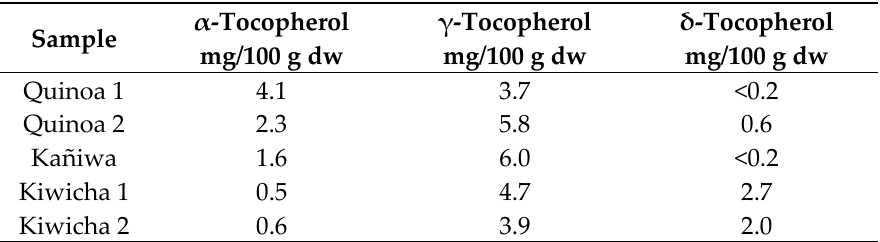
Table 4. Content of tocopherols in Andean grains.